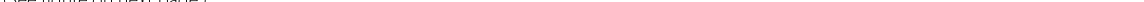
figure on next Fig. 2 No metabolic changes under normal chow diet (ND) in miR-100 mice. a – d There was no difference in the weight of liver ( a ), brown fat tissue ( b ), subcutaneous fat ( c ) and visceral fat ( d ) at the end of the 16 weeks ND feeding period (age 18–19 weeks) in miR-100 overexpressing mice in comparison to the wildtype controls. e – h The expression of lipogenic genes in the liver of miR-100 mice was not significantly altered as seen by quantitative real-time PCR analysis compared to WT animals. i , j The intraperitoneal glucose tolerance test at the end of the feeding period revealed no difference in WT and miR-100 mice. k , l The intraperitoneal insulin tolerance test at the end of the feeding period showed no change in miR-100 mice compared to wildtype controls. (n 5–6 for all experiments) Data represent mean values with SEM. n.s. not significant vs. the corresponding =